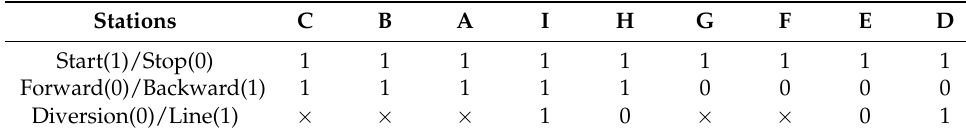
Table 1. Train Path with Station Settings.